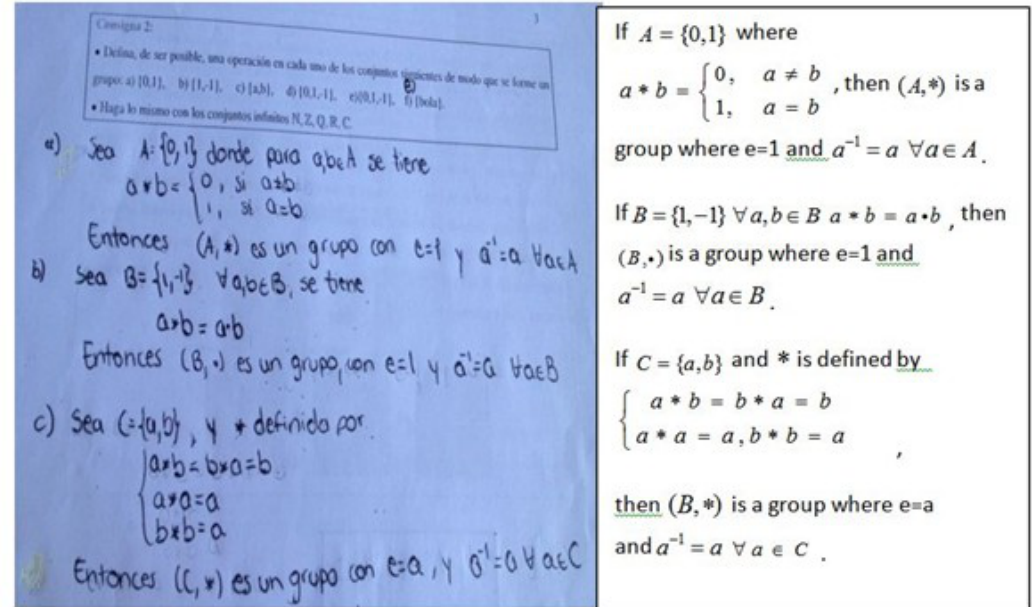
Figure 2. Creaton of groups of order two